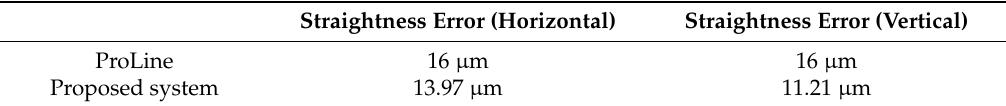
Figure 20. Case 1 straightness error measurement setup. Table 5. Case 1 straightness error measurement results.